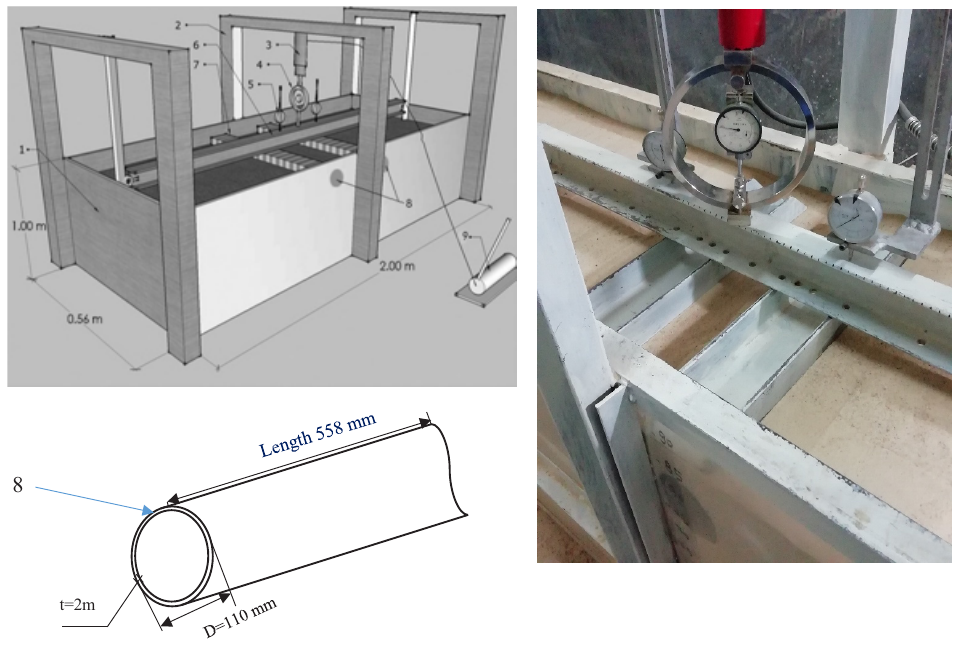
Figure 1: Schematic diagram of test setup: 1) steel test box; 2) steel load frame; 3) hydraulic jack; 4) proving ring; 5) dial gauge; 6) steel beam; 7) model steel footing; 8) cavities (PVC 110 mm); 9) roller